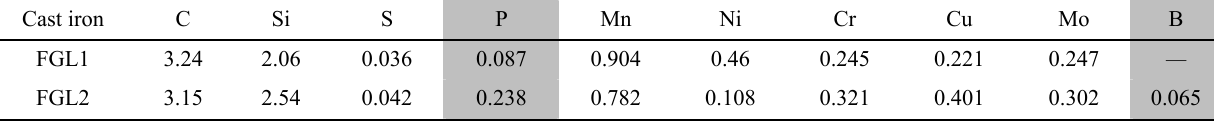
Table 1 Chemical composition (% in weight) of the studied cast irons. Cast iron